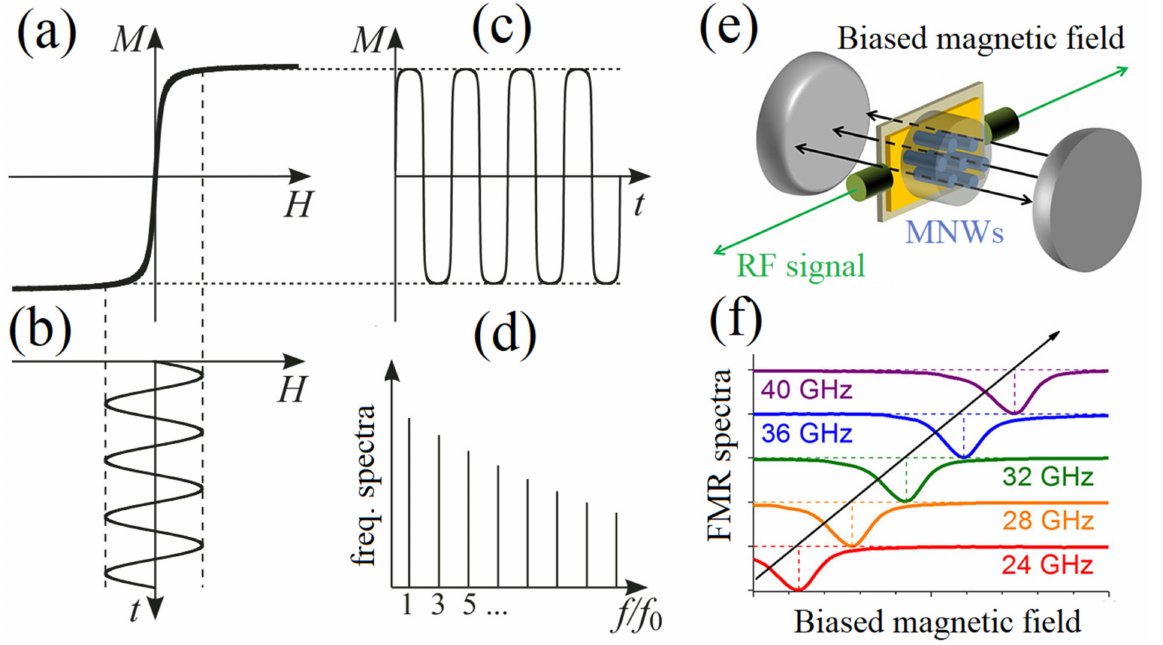
Figure 6. Schematically demonstrating ( a – d ) magnetic particle spectroscopy data, adapted from [127], and ( e , f ) ferromag- netic resonance spectroscopy data, adapted from [123]. In magnetic particle spectroscopy, superparamagnetic nanoparticles are exposed to an alternating magnetic field ( b ), which forces them to oscillate ( c ). By linearizing their response in frequency domain, multiple peaks appear at odd higher frequencies ( d ) that are being used for sensing them. In magnetic resonance spectroscopy, the MNWs are exposed to an RF signal while a biased magnetic field is applied. By sweeping the RF signal frequency or the biased magnetic field magnitude, the RF absorption of the MNWs varies due to their spins’ precession, where the absorption signal is being used for sensing the